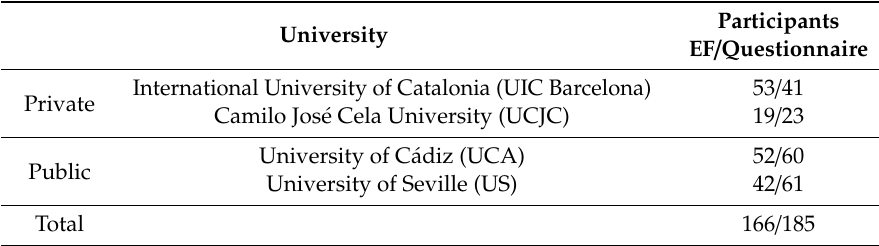
Table 1. Participants from each